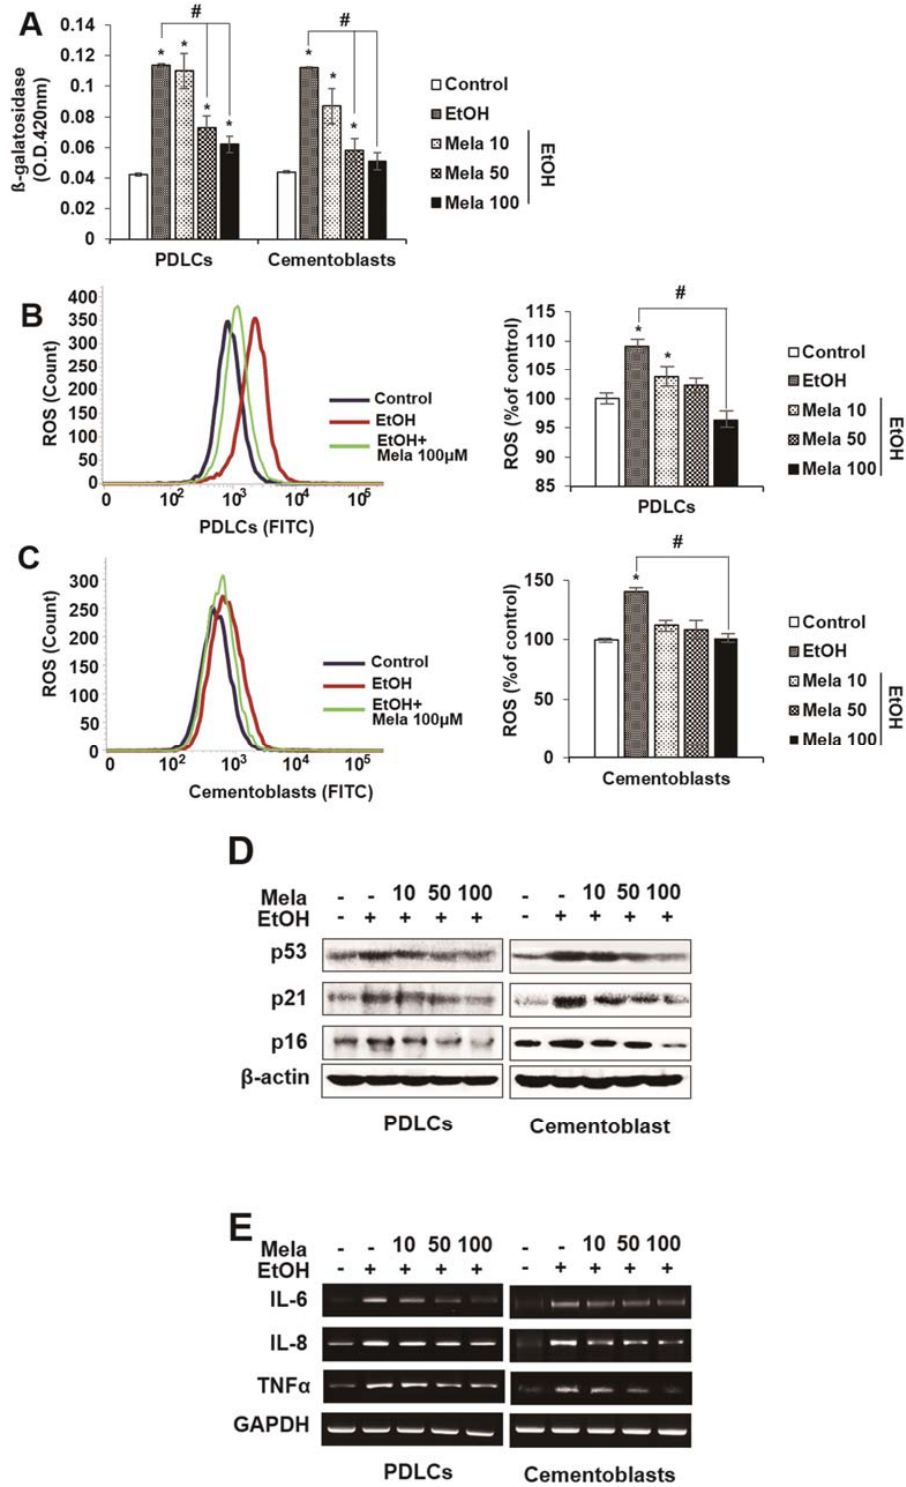
Figure 4. Effect of melatonin on EtOH-induced cellular senescence in PDLCs and cementoblasts. Cells are incubated with indicated concentration of melatonin ( µ M) and EtOH (25 mM) for 3 days ( A – C ). Senescence was examined by β -gal activity ( A ), ROS production ( B , C ) and expression of senescence-associated proteins ( D ) and mRNAs ( E ). These data are representative of three independent experiments. *: statistically significant difference compared to the control groups ( p < 0.05). # : statistically significant difference in each group.